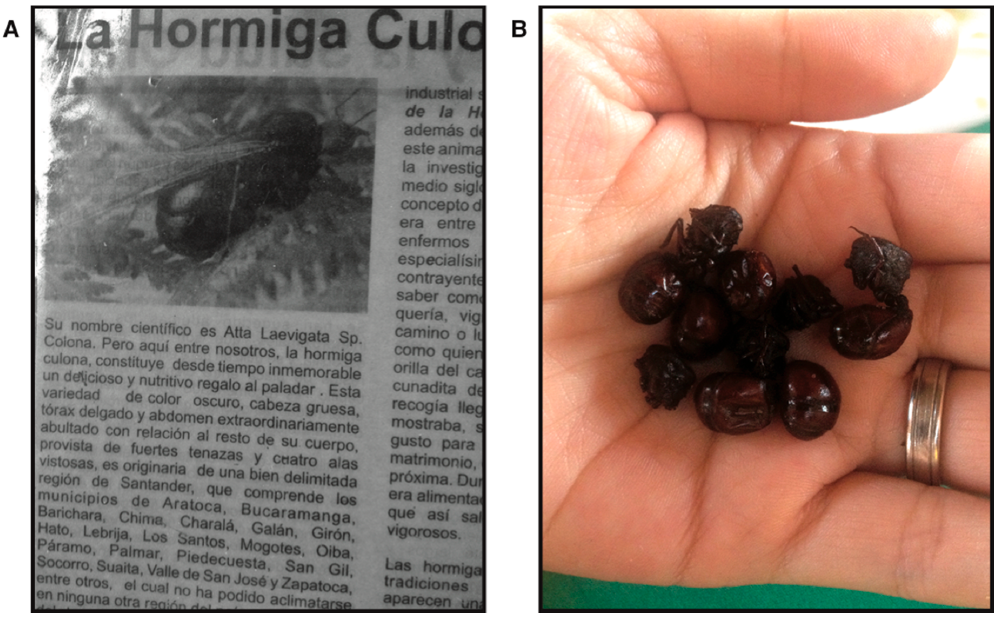
Figure 1. ( A ) Newspaper clipping found at the local store selling fried ants, i.e., “hormigas culonas”, as A. laevigata . The first two sentences translate to: “Its scientific name is Atta laevigata . But among